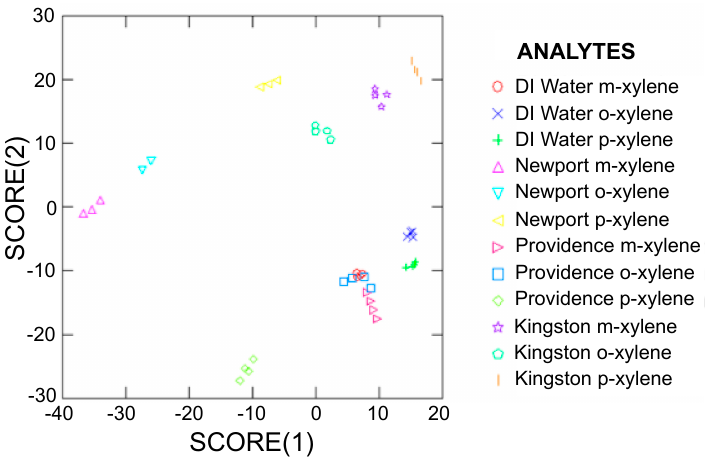
Figure 10. Linear discriminant analysis of fluorescence response patterns of analytes 4 – 6 with fluorophore 9 in Newport snow, Providence snow, Kingston snow, and deionized water, with cyclodextrins as predictors.